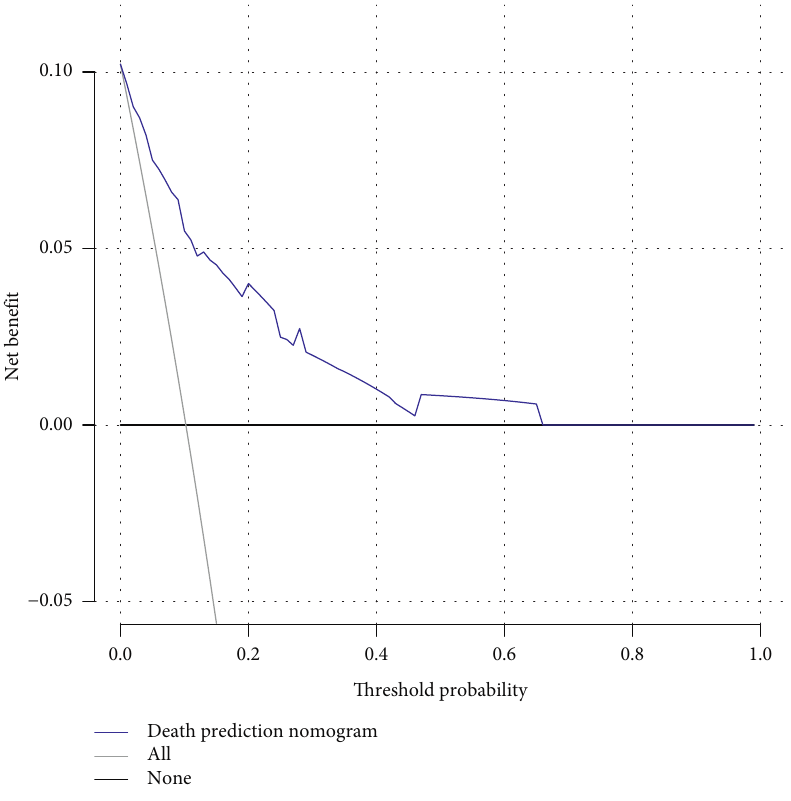
Figure 5: Decision curve analysis for the nomogram.